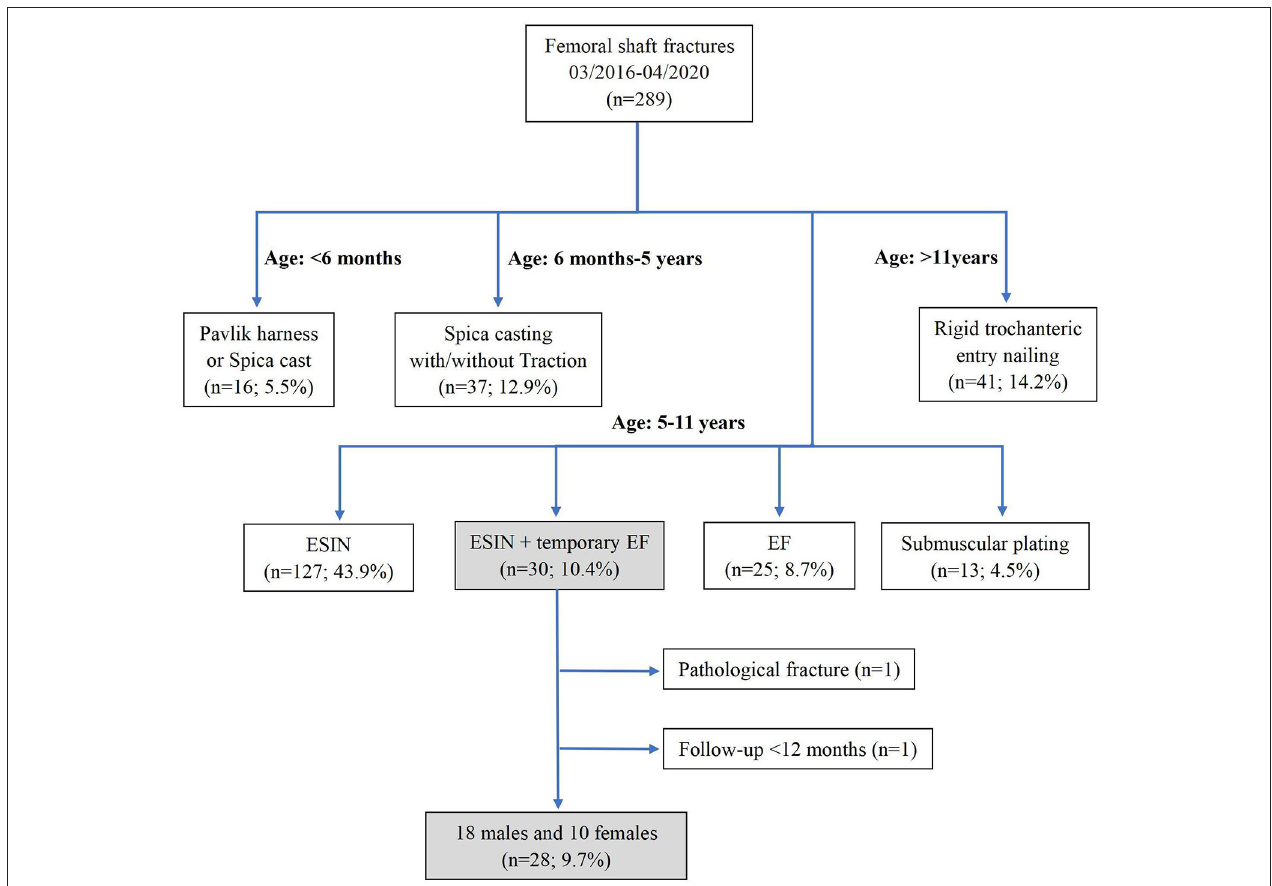
FIGURE 1 | Flowchart of